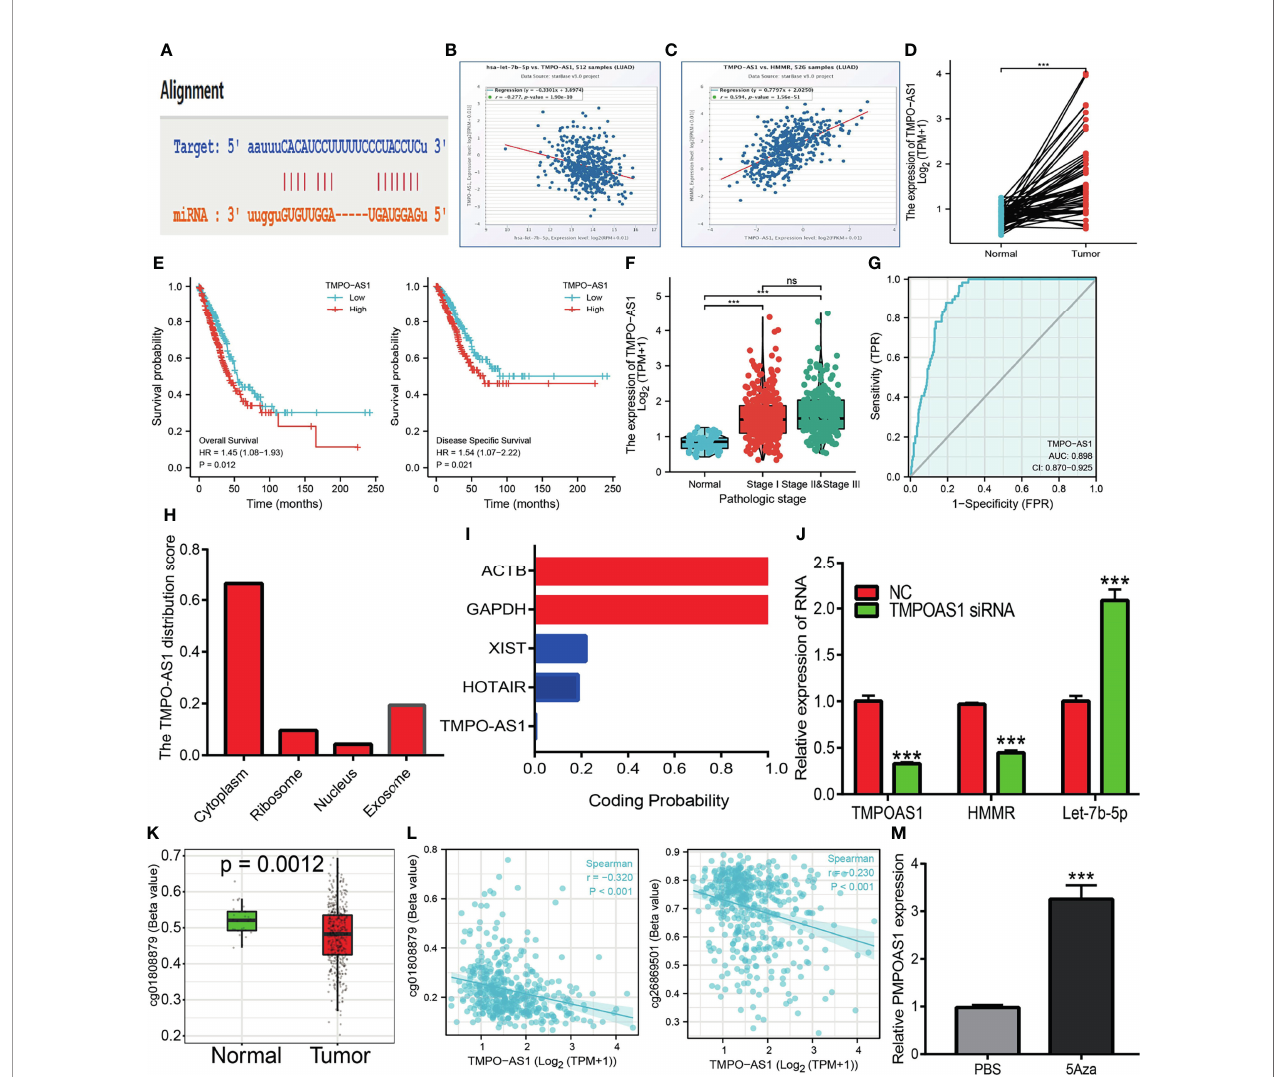
FIGURE 9 | Predicted and analysis the upstream LncRNAs of let-7b-5p in LUAD. (A) The target sites between the TMPO-AS1 and hsa-let-7b-5p were predicted by starbase. (B) The correlation between hsa-let-7b-5p expression and TMPO-AS1 analysis by starbase. (C) The correlation between the HMMR expression and TMPO-AS1 analysis by starbase. (D) The expression of TMPO-AS1 in LUAD analysis by starbase. (E, F) The prognosis of TMPO-AS1 in LUAD analysis by kmplot. (G) The ROC curve of TMPO-AS1 in LUAD. (H) The subcellular localization of TMPO-AS1 analysis by the lncLocator tools. (I) The coding potential of TMPO-AS1 analysis by the coding potential calculator. (J) The HMMR and hsa-let-7b-5p expression after depletion of TMPO-AS1 in LUAD cells analysis by qRT-PCR assay. (K) The DNA methylation of TMPO-AS1 in LUAD. (L) The correlation between DNA methylation and expression of TMPO-AS1 in LUAD. (M) The expression of TMPO-AS1 in LUAD cells after treat with 5Aza examined by qRT-PCR assay. P >0.05 (ns), P < 0.001 (***), was considered signi fi